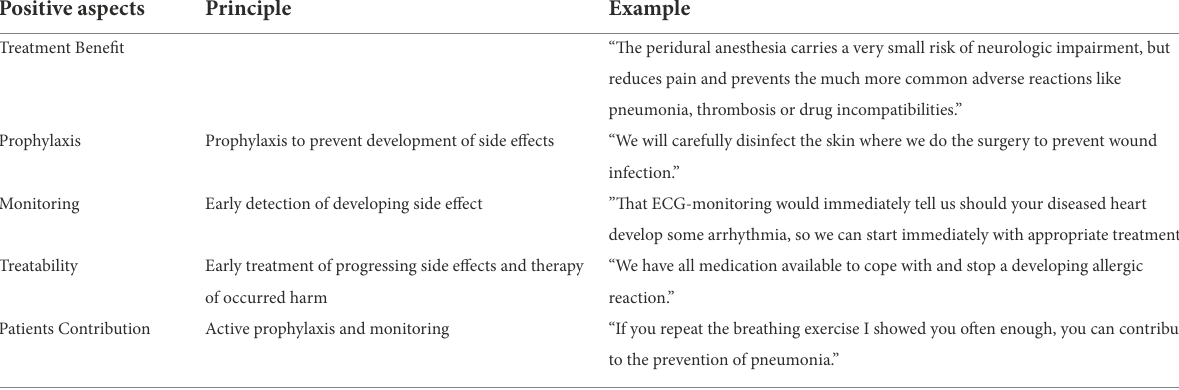
TABLE 5 Options for neutralization of nocebo effect induction during risk disclosure by simultaneous presentation of positive aspects.